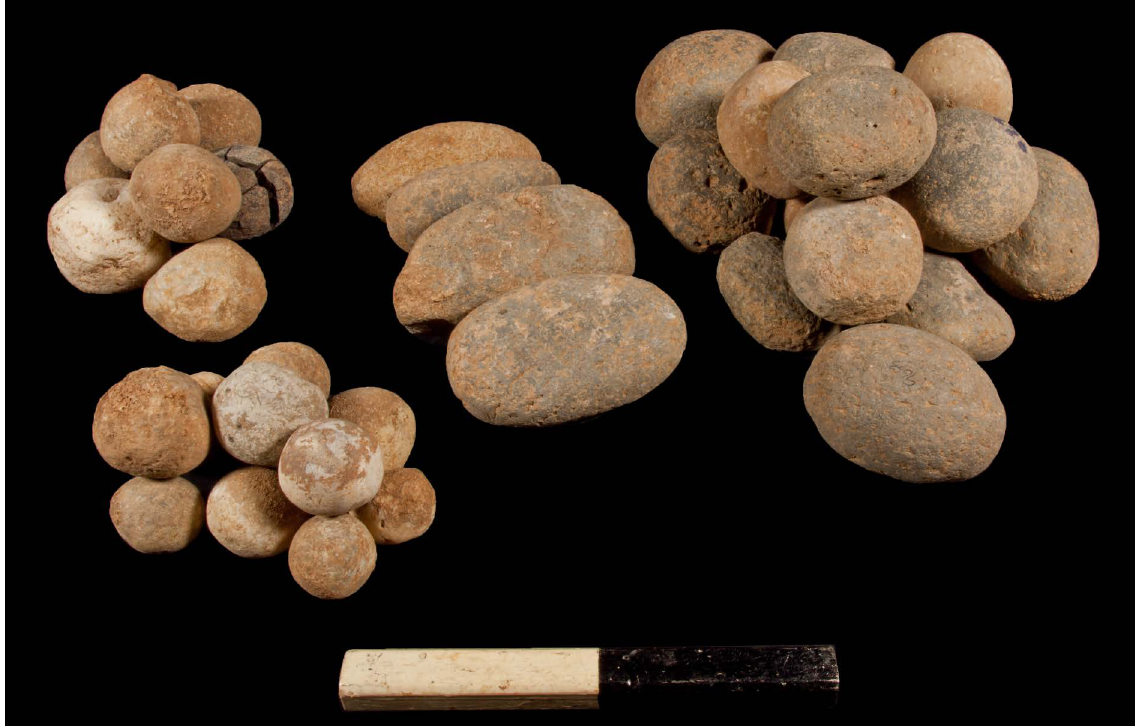
Figure 10. Cobbles from Iron Age I Tel Dan: some of these could have functioned as crank drill or borer weights (the two groupings on the right; the small spherical cobbles on the left are too